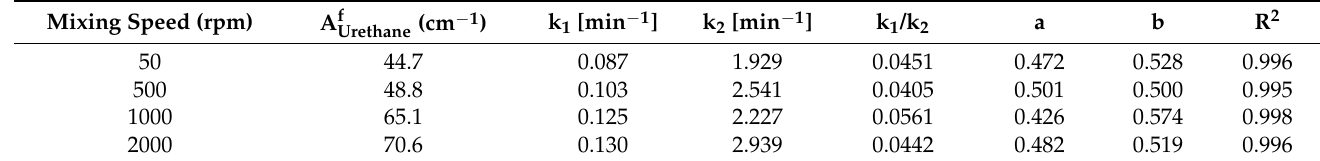
Table 8. Effect of mixing speed on Urea formation: results of the fitting